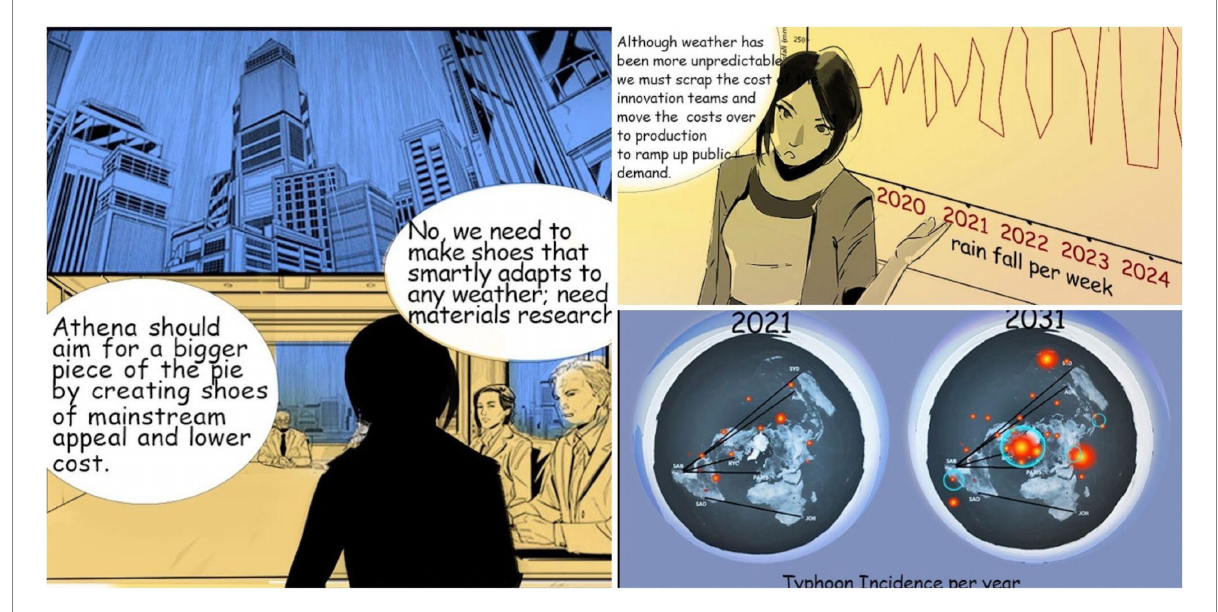
FIGURE 3 Using data visuals to describe future scenarios in the context of the narrative in Sonia McDougal .